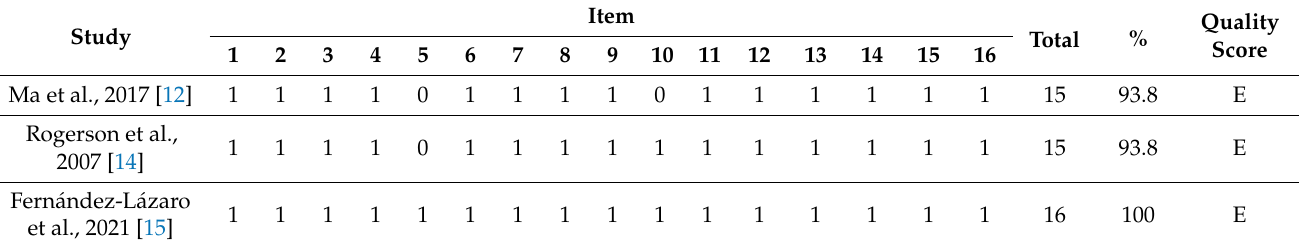
Table 1. Results of the methodological quality assessment of included studies—McMaster Critical Review Form for Quantitative Studies